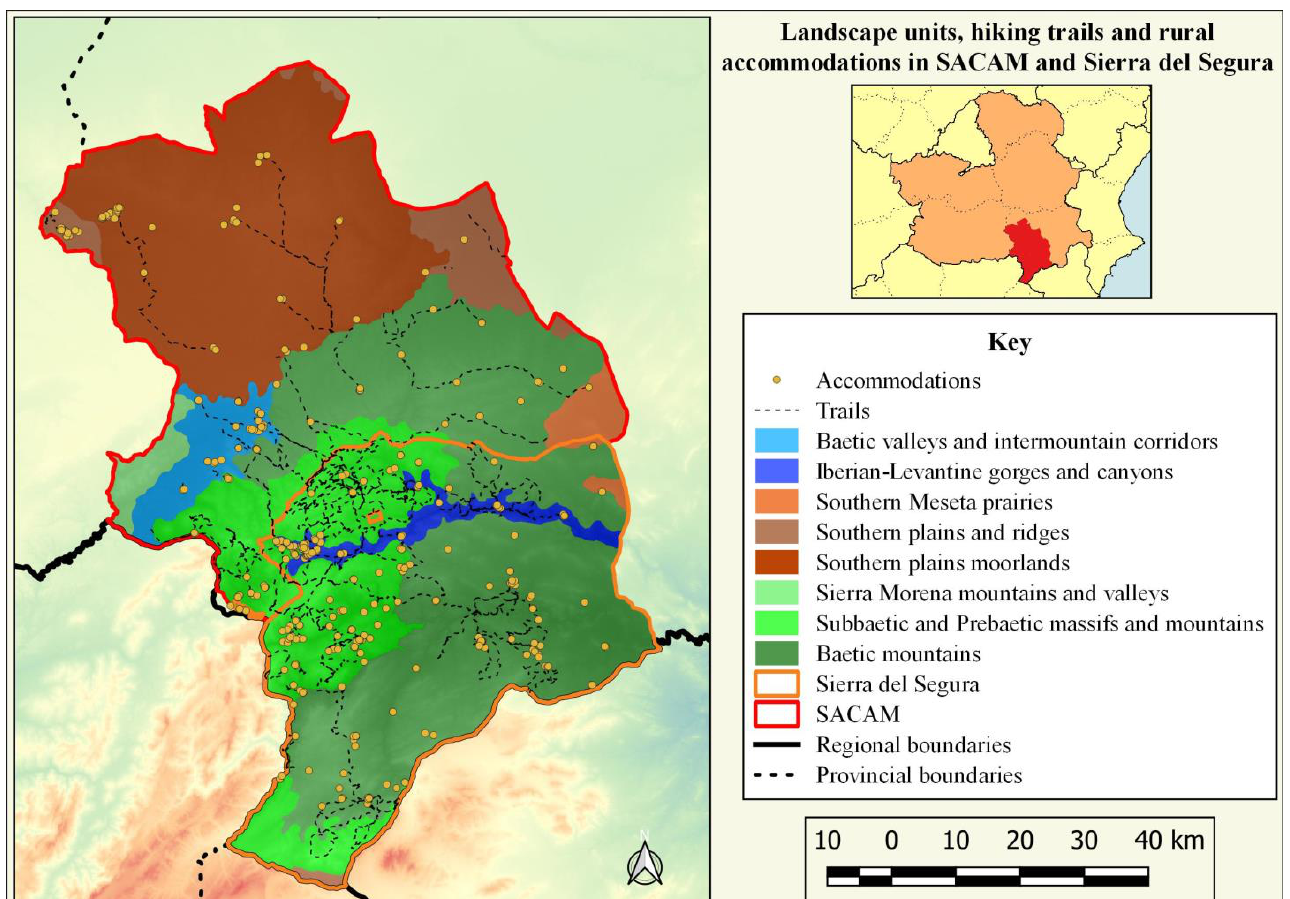
Land 2021 , 10 , x FOR PEER REVIEW 15 of 19